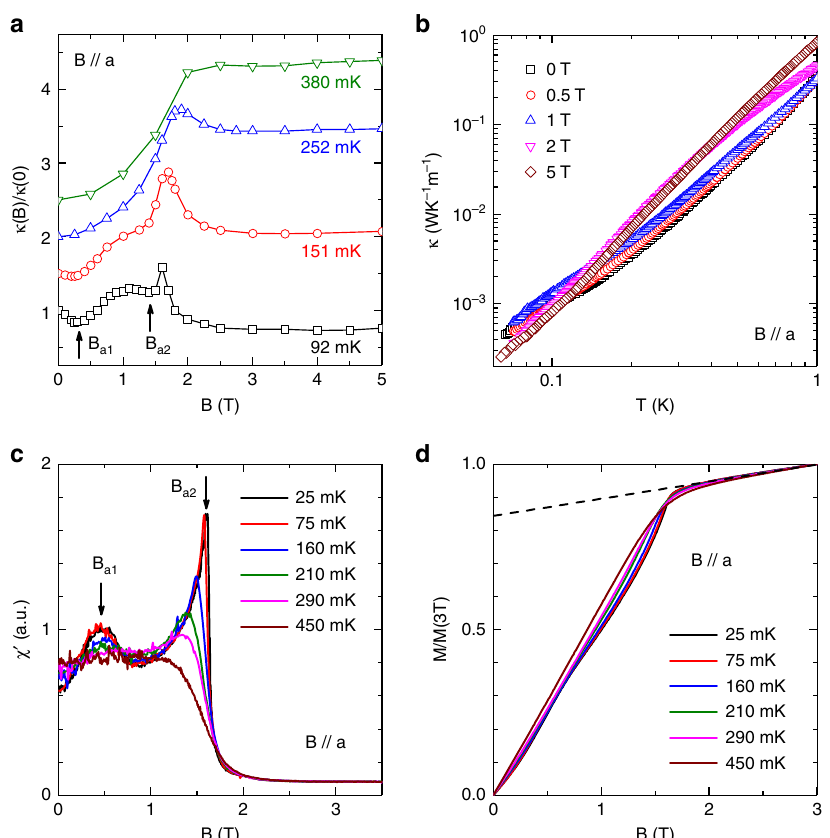
Fig. 5 Thermal conductivity and AC susceptibility of Na 2 BaCo(PO 4 ) 2 for B // a . a Magnetic- fi eld dependence of thermal conductivity at different temperatures. For clarifying, the 151 mK, 252 mK and 380 mK curves are shifted upward by 0.5, 1.0 and 1.5, respectively. At very low temperatures, there are two minima on the κ ( B ) curves which disappear above 252 mK. b Temperature dependence of κ in different fi elds. No clear anomaly is observed. c AC magnetic susceptibility at different temperatures. There are two peaks in the low-temperature curves. d Magnetization curves obtained by integrating the AC susceptibility data and renormalized with the 3 T value. The dashed line indicates the Van Vleck paramagnetic